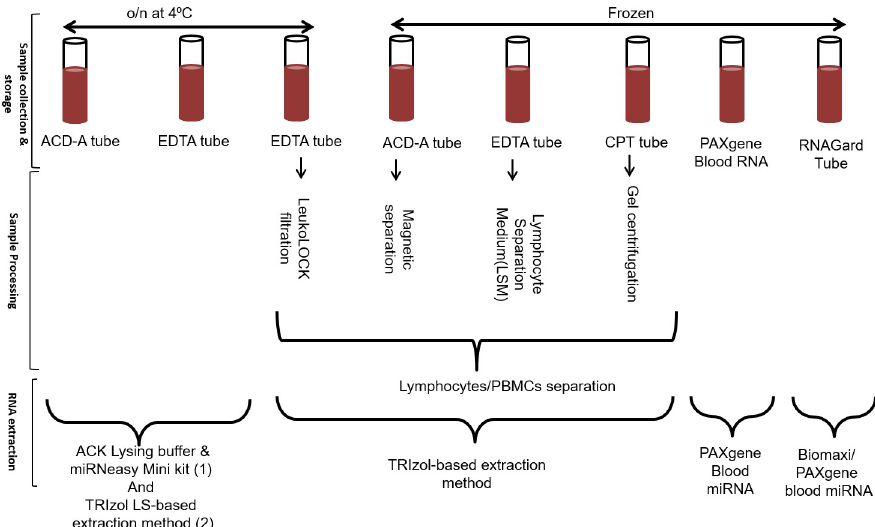
Fig 1. Sample collection, processing and RNA extraction: Whole blood was collected in triplicate followed by peripheral blood mononuclear cells (PBMCs) separation in a subset of samples. The following sample collection tubes were used for the study: RNAgard 1 , PAXgene 1 RNA, EDTA, ACD-A, and CPT tubes. The PBMC separation was done using standard procedures for CPT tubes, and magnetic bead, LeukoLOCK ™ and LSM methods. The samples were then stored at either 4˚C (Cold) or -80˚C (Frozen) and shipped overnight (o/n) for follow-up RNA extraction. Next, they were treated with one or more of several different RNA extraction procedures: Biomaxi Precip Buffer/ PAXgene 1 Blood miRNA, PAXgene 1 Blood miRNA, TRIzol 1 LS, ACK Lysing Buffer/ Qiagen miRNeasy, and TRIzol 1 Reagent manufacturer’s protocol.